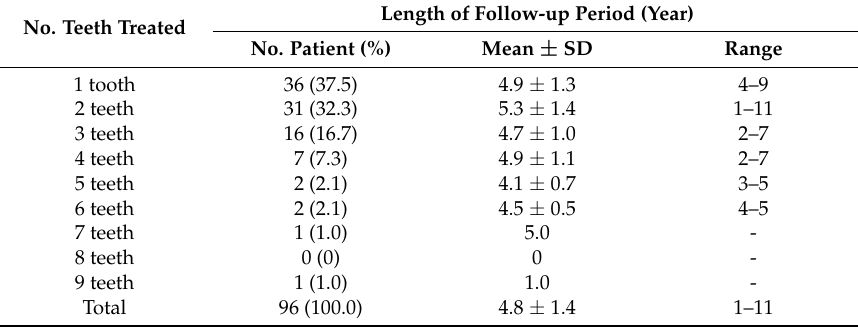
Table 1. Distribution of the number of patients and the length of the follow-up period according to the number of teeth treated.